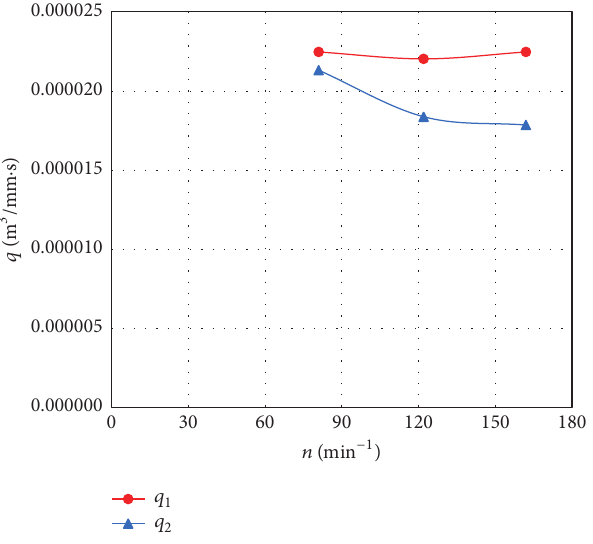
Figure 16: Flow rate per unit blade width. Figure 17: Angular momentum per unit blade width and unit